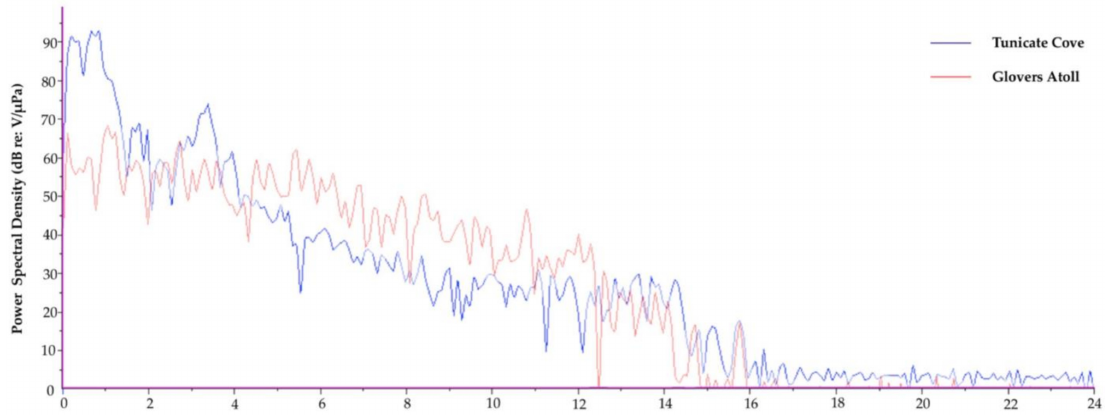
Figure 3. Dominant frequency plots comparing Tunicate Cove, Belize (blue) and Glovers Atoll, Belize (green). Table 4. Example of soundscape features from a healthy coral reef at Tunicate Cove and a shallow mangrove–sand habitat in Belize. Each mean and standard deviation (S.D.) were calculated from n = 20 1-s selections from a total 20-s sound